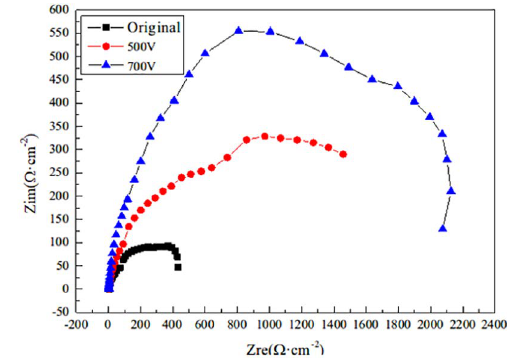
Figure 4. Nyquist pots of aluminum brass alloy in 3.5%